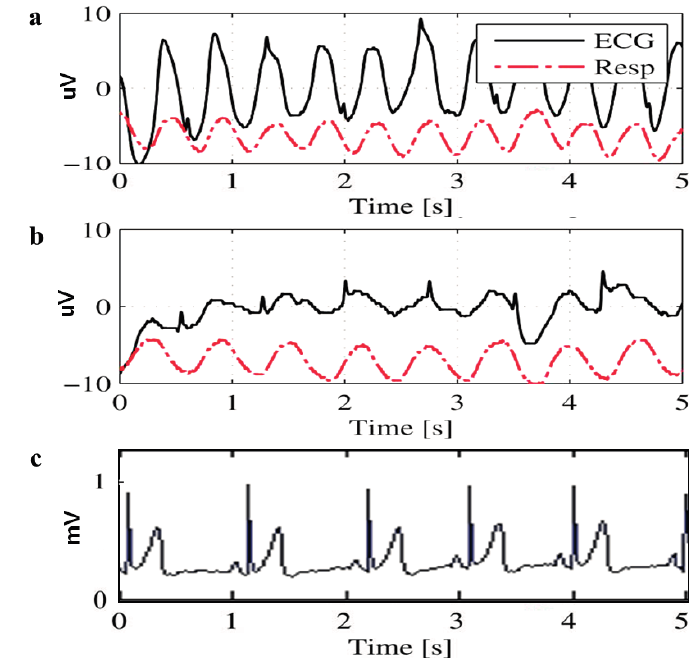
Figure 6. Comparison of ECG signals measured from grid-electrode (with permission from [11]) and the proposed FEEP. ( a ) The active driven grid is switched off (it acts as metal-coated electrodes); ( b ) The active driven grid is switched on; ( c ) The proposed sensor electrodes